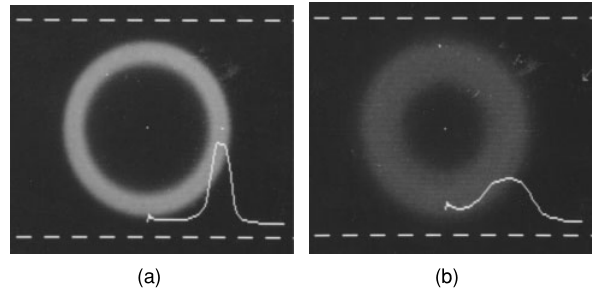
Figure 2 The 2-D image and the horizontal intensity profile of the far-field pattern measured at the center before (a) and after (b) the presence of perturbation.